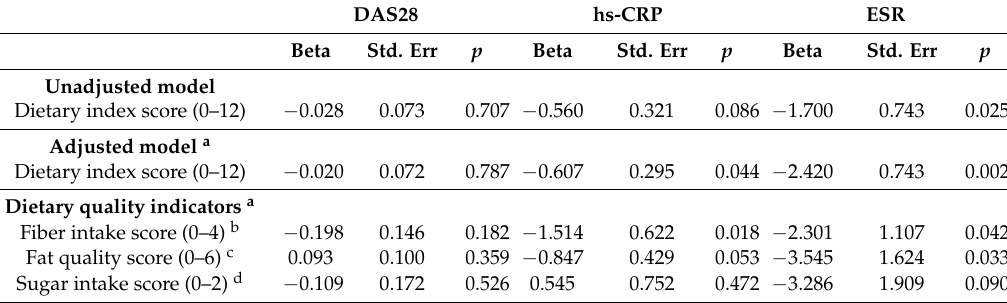
Table 3. Associations between dietary quality and Disease Activity Score 28 (DAS28), high sensitivity C-reactive protein (hs-CRP) and erythrocyte sedimentation rate (ESR) among 66 Swedish patients with rheumatoid arthritis.